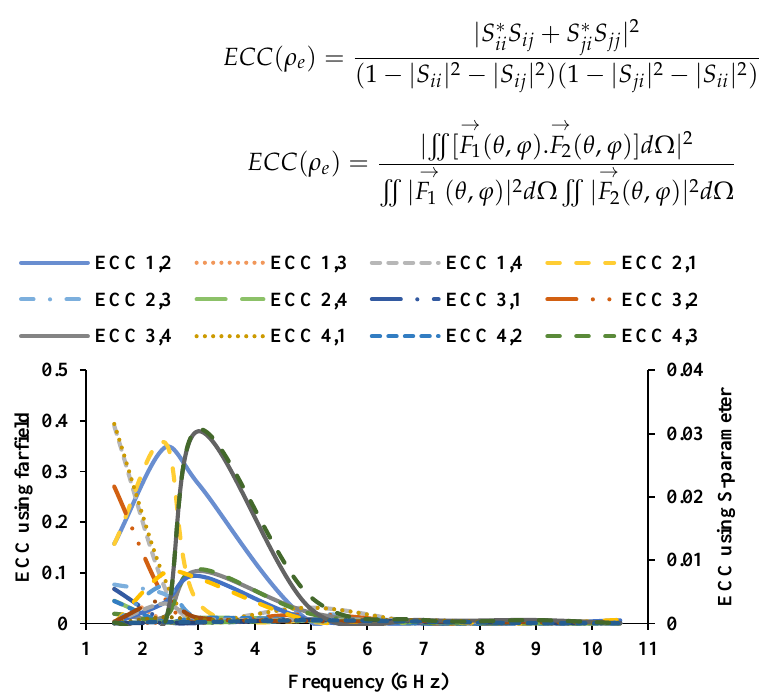
Figure 14. ECC of the MIMO antenna.